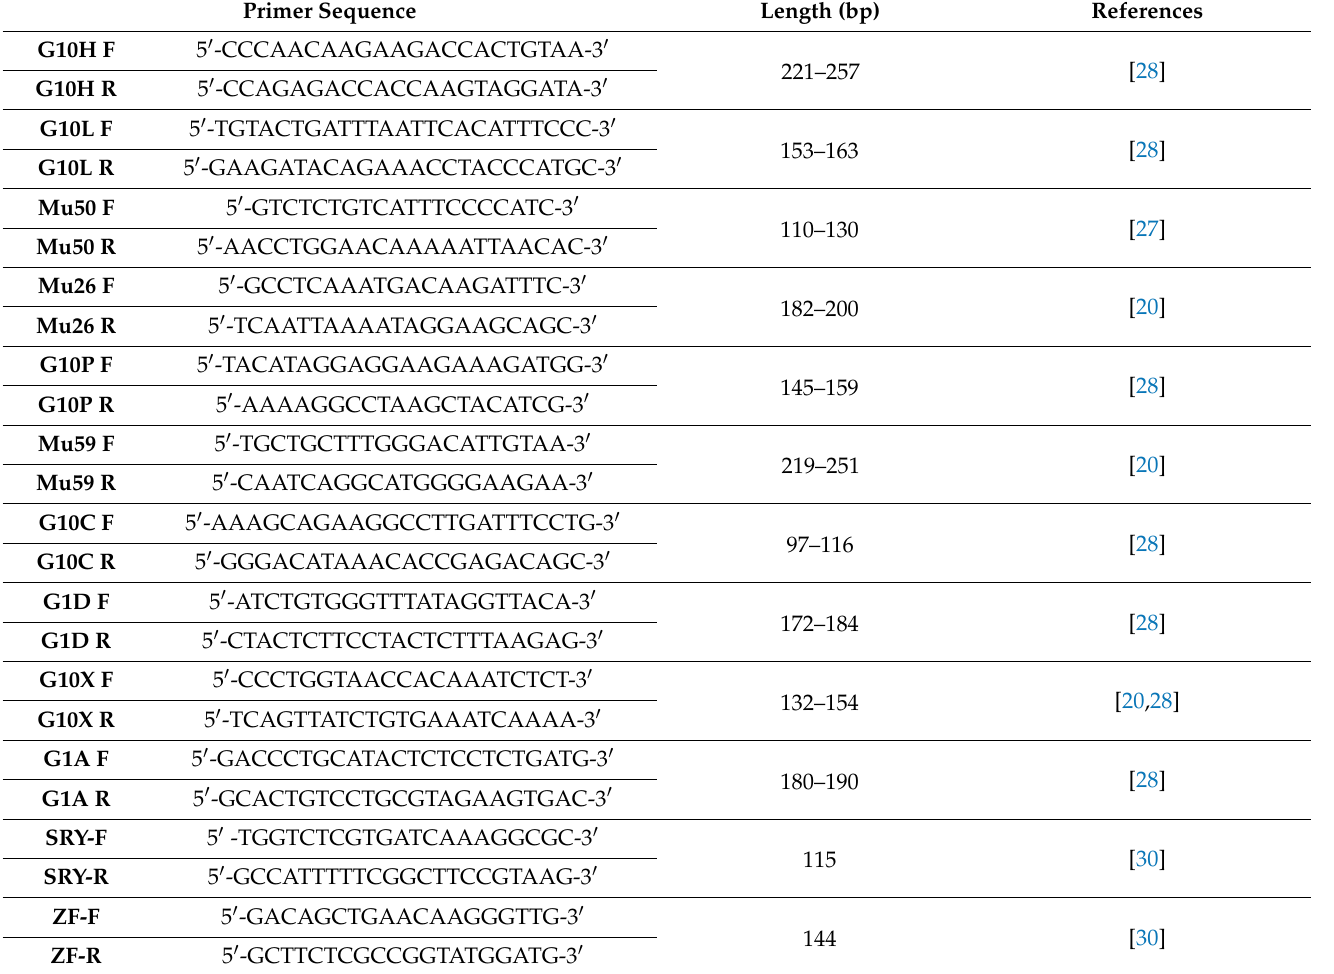
Table 1. Primer sequence and length of the 10 microsatellite